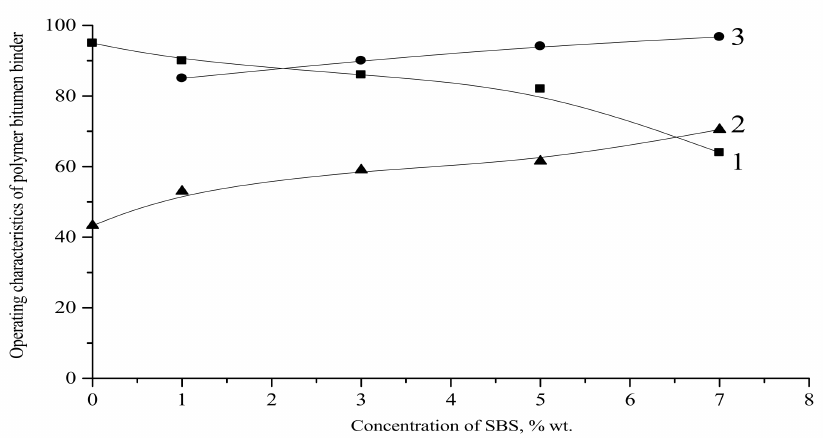
Figure 1. Dependence of depth of penetration (1), ring and ball softening point (2), elasticity (3) on SBS concentration.